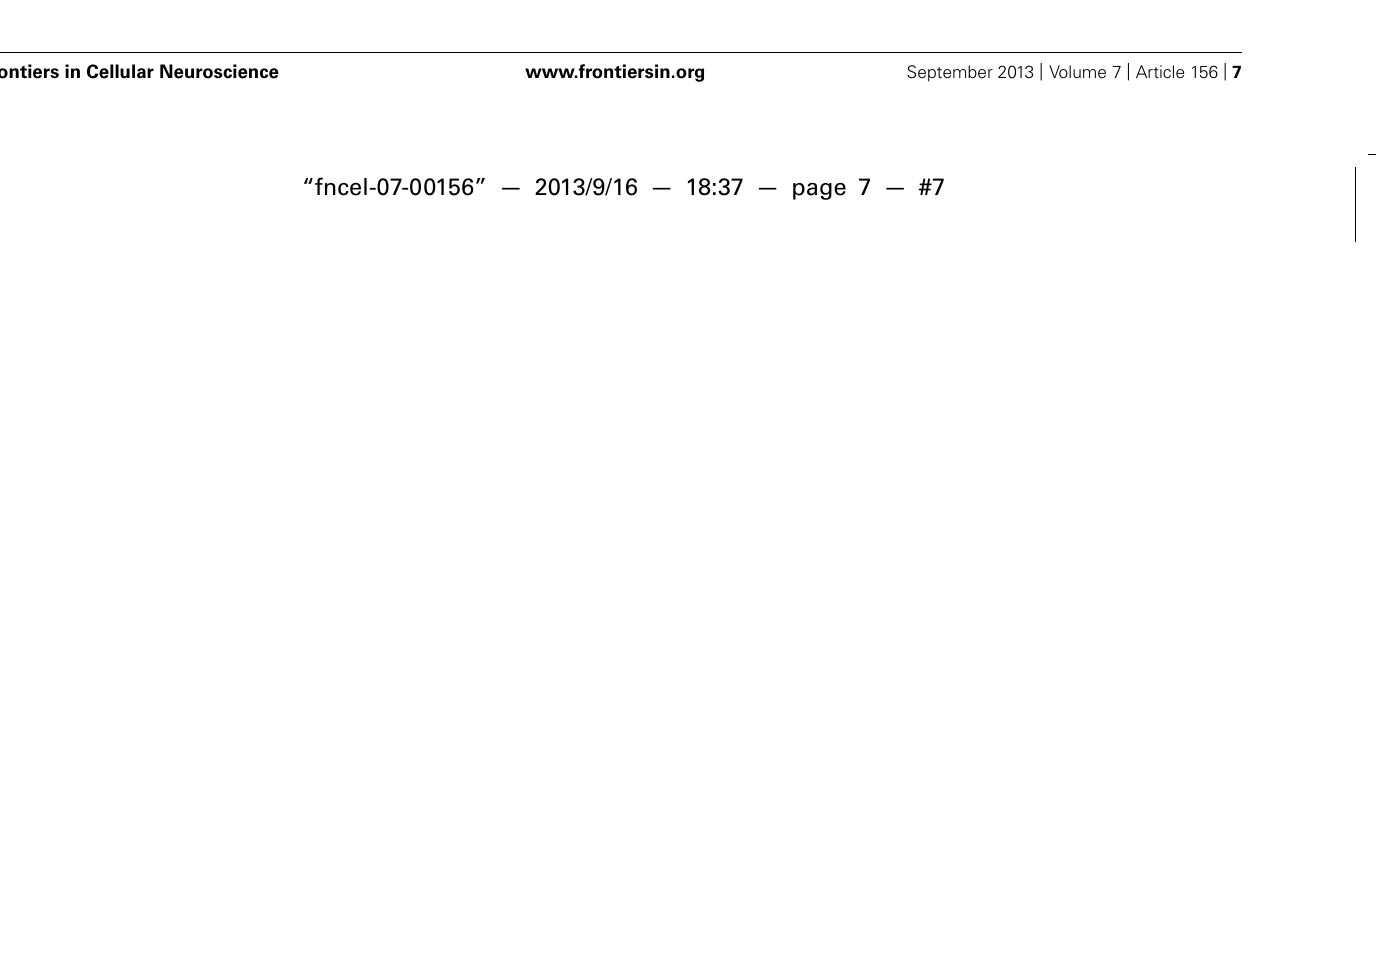
increasing doses of MK-801. (C) Graphical representation of divergent response to increasing doses of MK-801 inWT and stargazer mice (* p < 0.05, ** p < 0.005). In (D) , there is a coordinate reduction in discharge duration with no significant difference between groups at each incremental concentration of